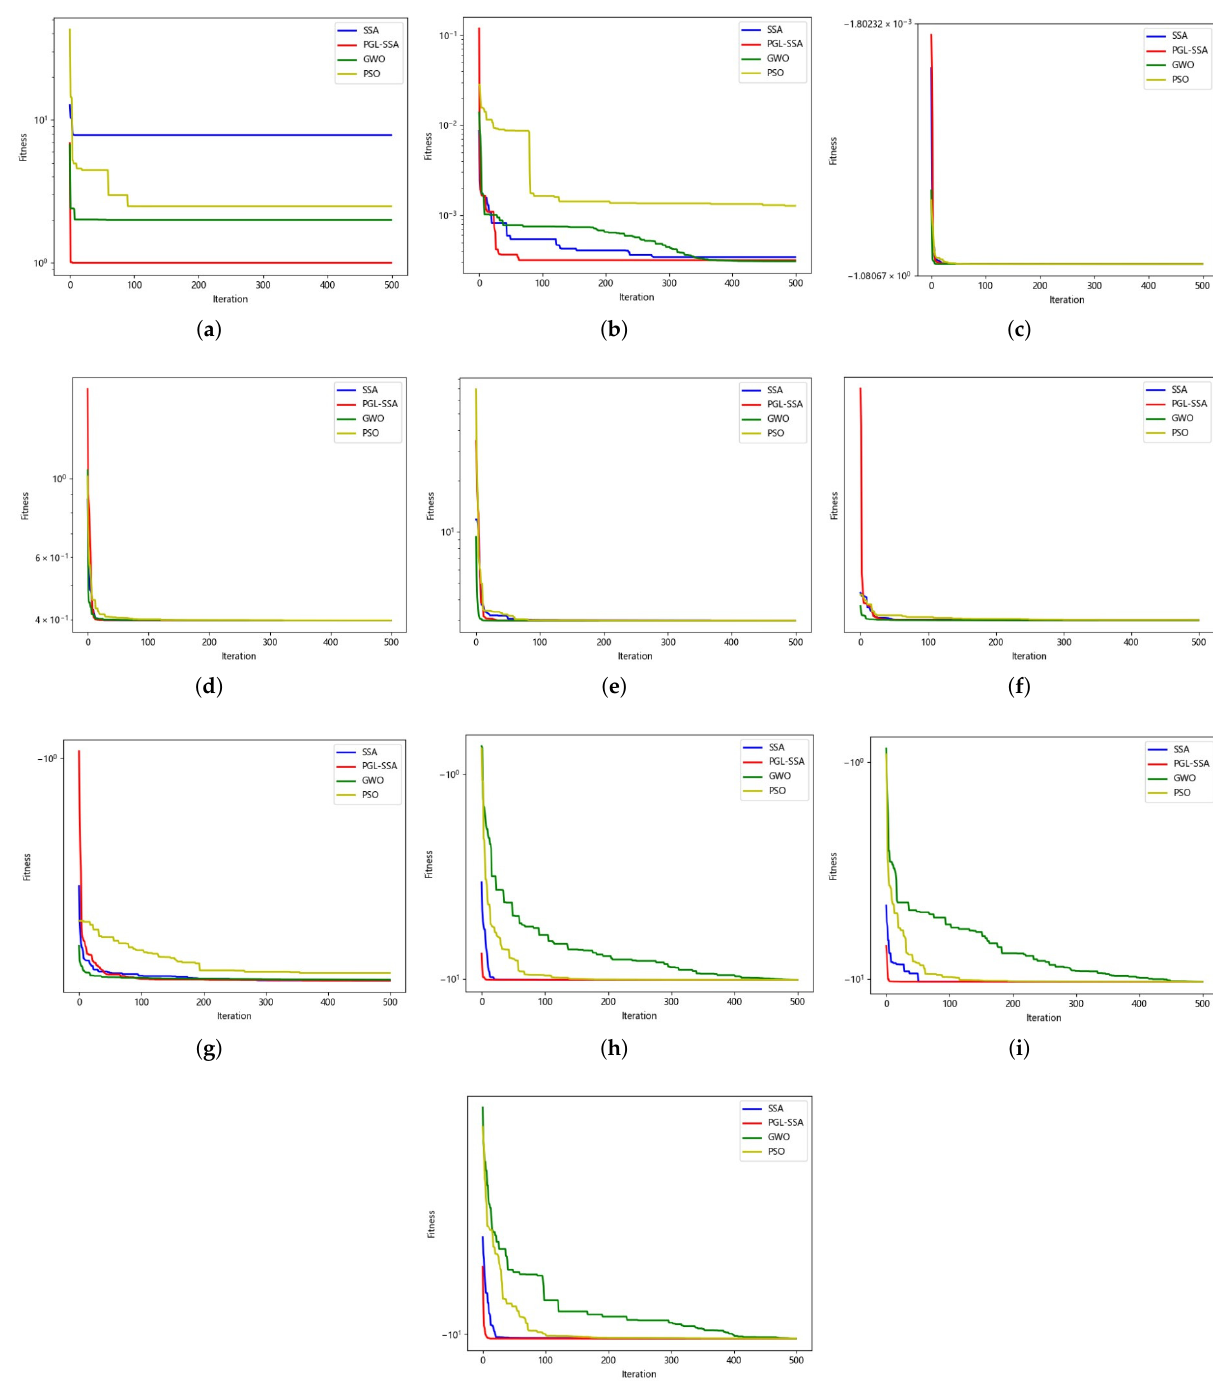
Figure 6. Convergence curves of fixed-dimensional peak functions for different algorithms. ( a ) F12 Convergence curve. ( b ) F13 Convergence curve. ( c ) F14 Convergence curve. ( d ) F15 Convergence curve. ( e ) F16 Convergence curve. ( f ) F17 Convergence curve. ( g ) F18 Convergence curve. ( h ) F19 Convergence curve. ( i ) F20 Convergence curve. ( j ) F21 Convergence